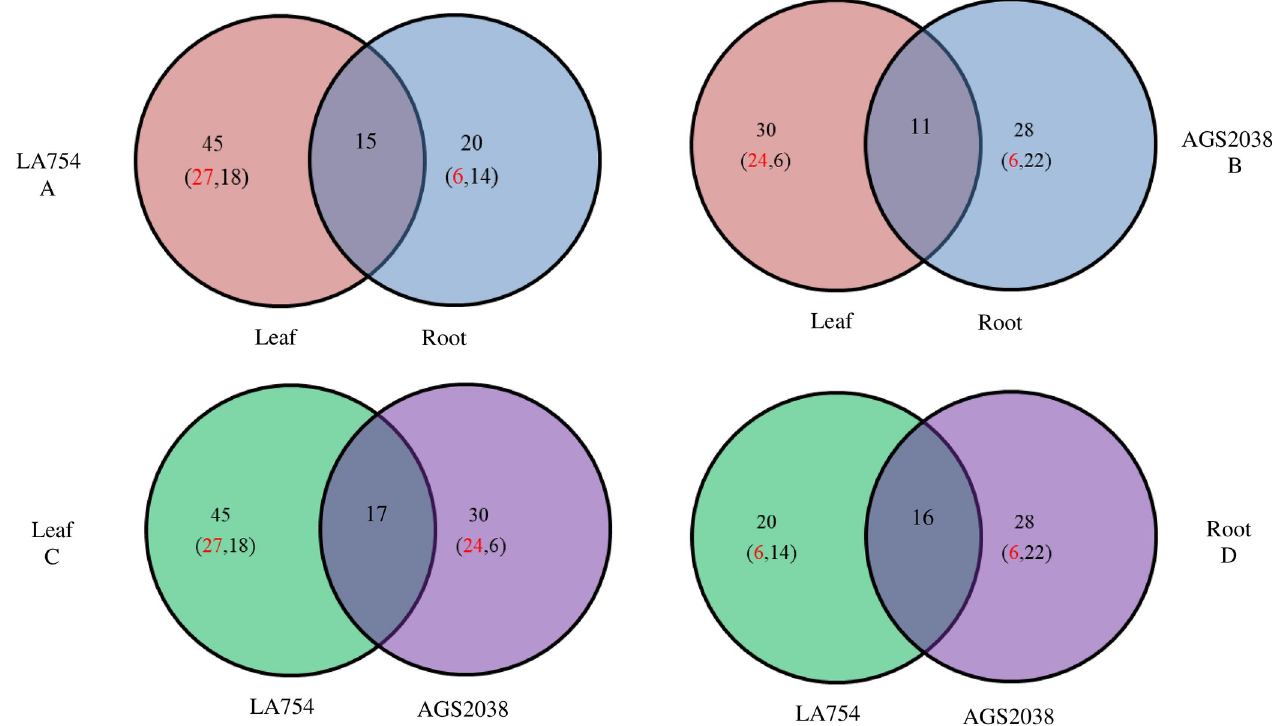
Fig 5. Total number of metabolites significantly regulated in drought compared to control. Colors indicate either two genotypes or leaf and root (orange = leaf, blue = root; green = ‘LA754’, purple = ‘AGS2038’). Numbers in parenthesis indicate number of metabolites up-regulated (red) and down- regulated